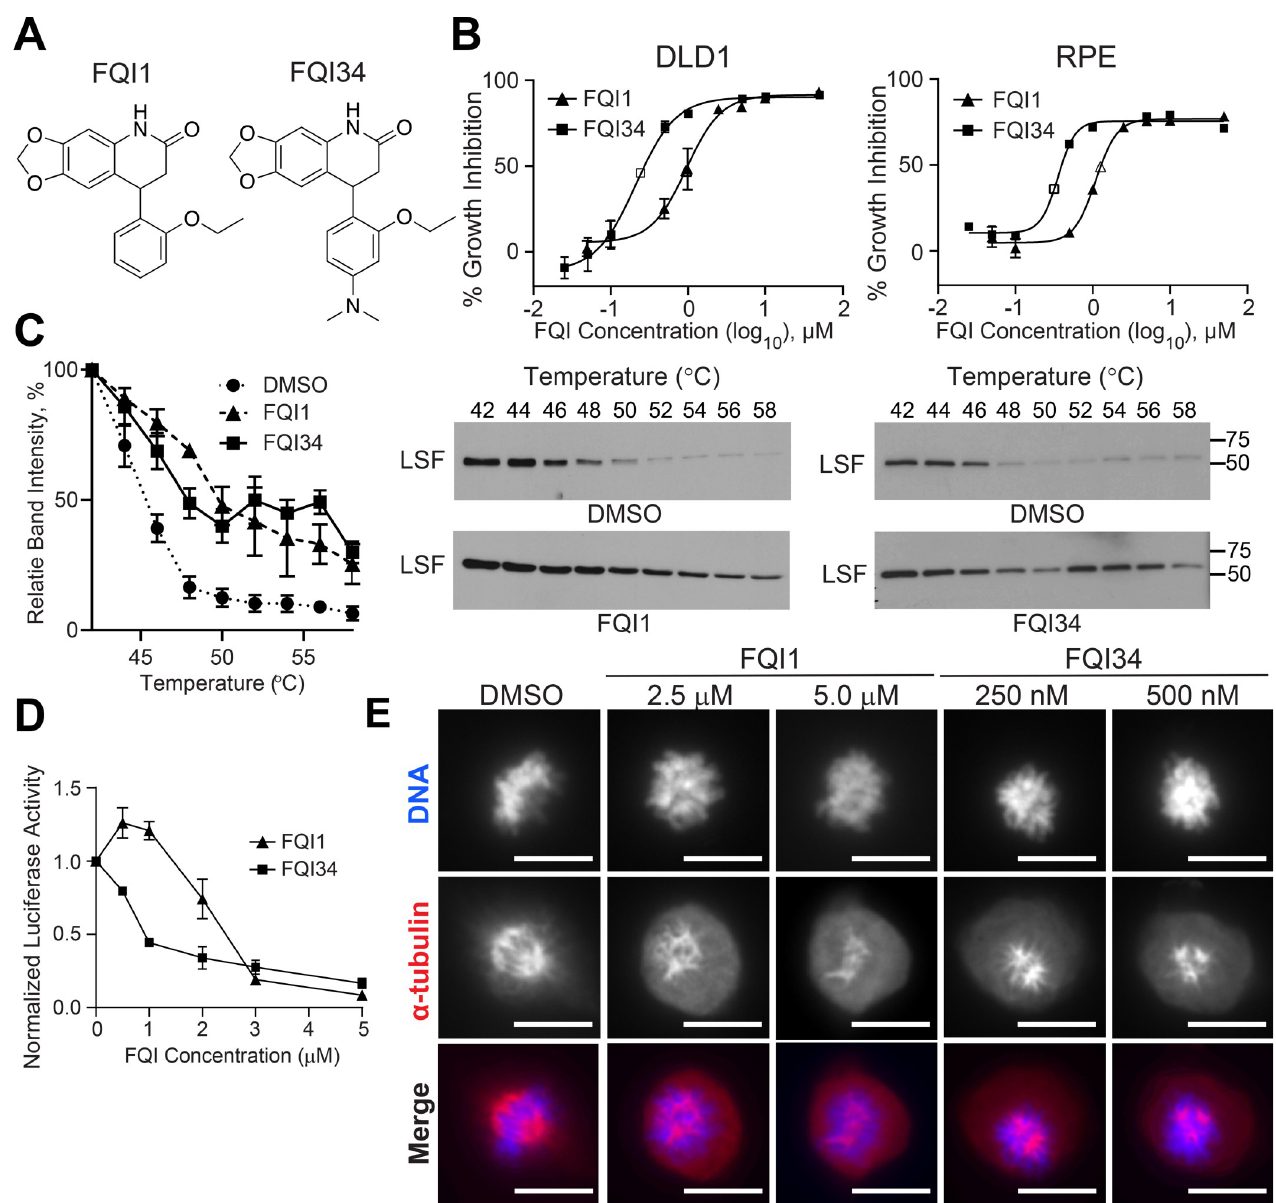
Fig 5. FQI34, a more potent LSF inhibitor, disrupts mitosis with spindle defects at 10-fold lower concentrations than FQI1. (A) Comparison of structures of FQI1 and FQI34. (B) MTS assays measuring the number of viable cells upon treatment of parental DLD-1 cells (left) and RPE cells (right) with increasing concentrations of FQI1 versus FQI34. Calculated GI50’s are: DLD-1 FQI1, 0.95 μ M; DLD-1 FQI34, 0.24 μ M; RPE FQI1, 1.25 μ M; RPE FQI34, 0.32 μ M. Data indicate averages +/- SEM from 6 replicates. (C) CETSAs showing increase in LSF thermal stability in presence of FQI1 versus FQI34. Left: Quantitation of remaining soluble LSF at indicated temperature, with averages +/- SEM from 3 independent experiments. Representative immunoblots of the primary data from FQI1 (middle) and FQI34 (right) CETSAs. (D) Inhibition of LSF-dependent reporter assays in cells treated with increasing concentrations of FQI1 versus FQI34. The reporter plasmid, with an LSF-dependent promoter driving luciferase expression, is described in S4 Fig (panel B). Data are averages +/- SEM from 3 independent experiments. (B-D) Detailed protocols are described in S1 File. (E) Representative images of RPE-hTERT-Flp-In cells synchronized and treated as in the schematic shown in Fig 4A, using the indicated concentrations of either FQI1 or FQI34. Cells were stained for α -tubulin and DNA.